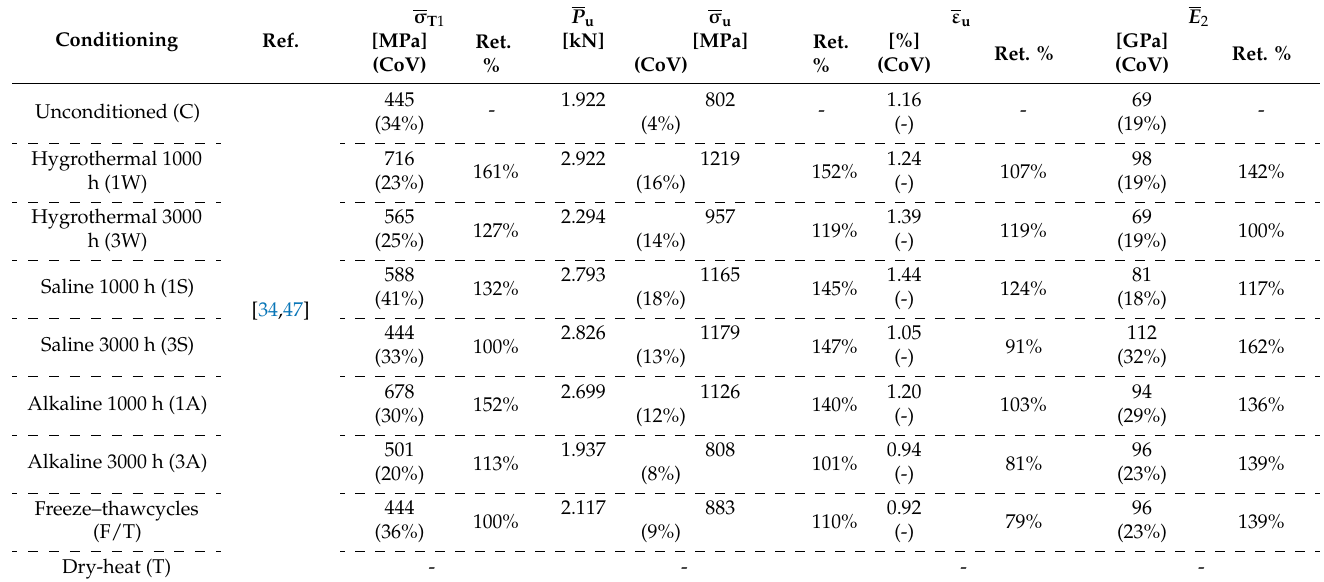
Table 4. Carbon FRCM: average results of conditioned specimen groups and retained values.